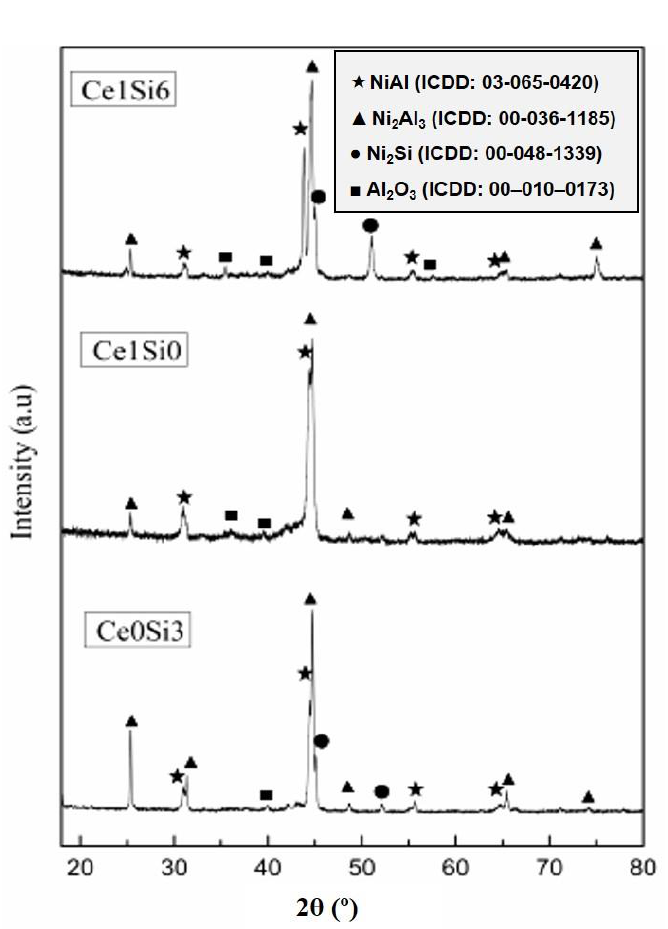
Figure 5. X-ray diffraction pattern of samples coated by pack cementation method at 1000 °C.